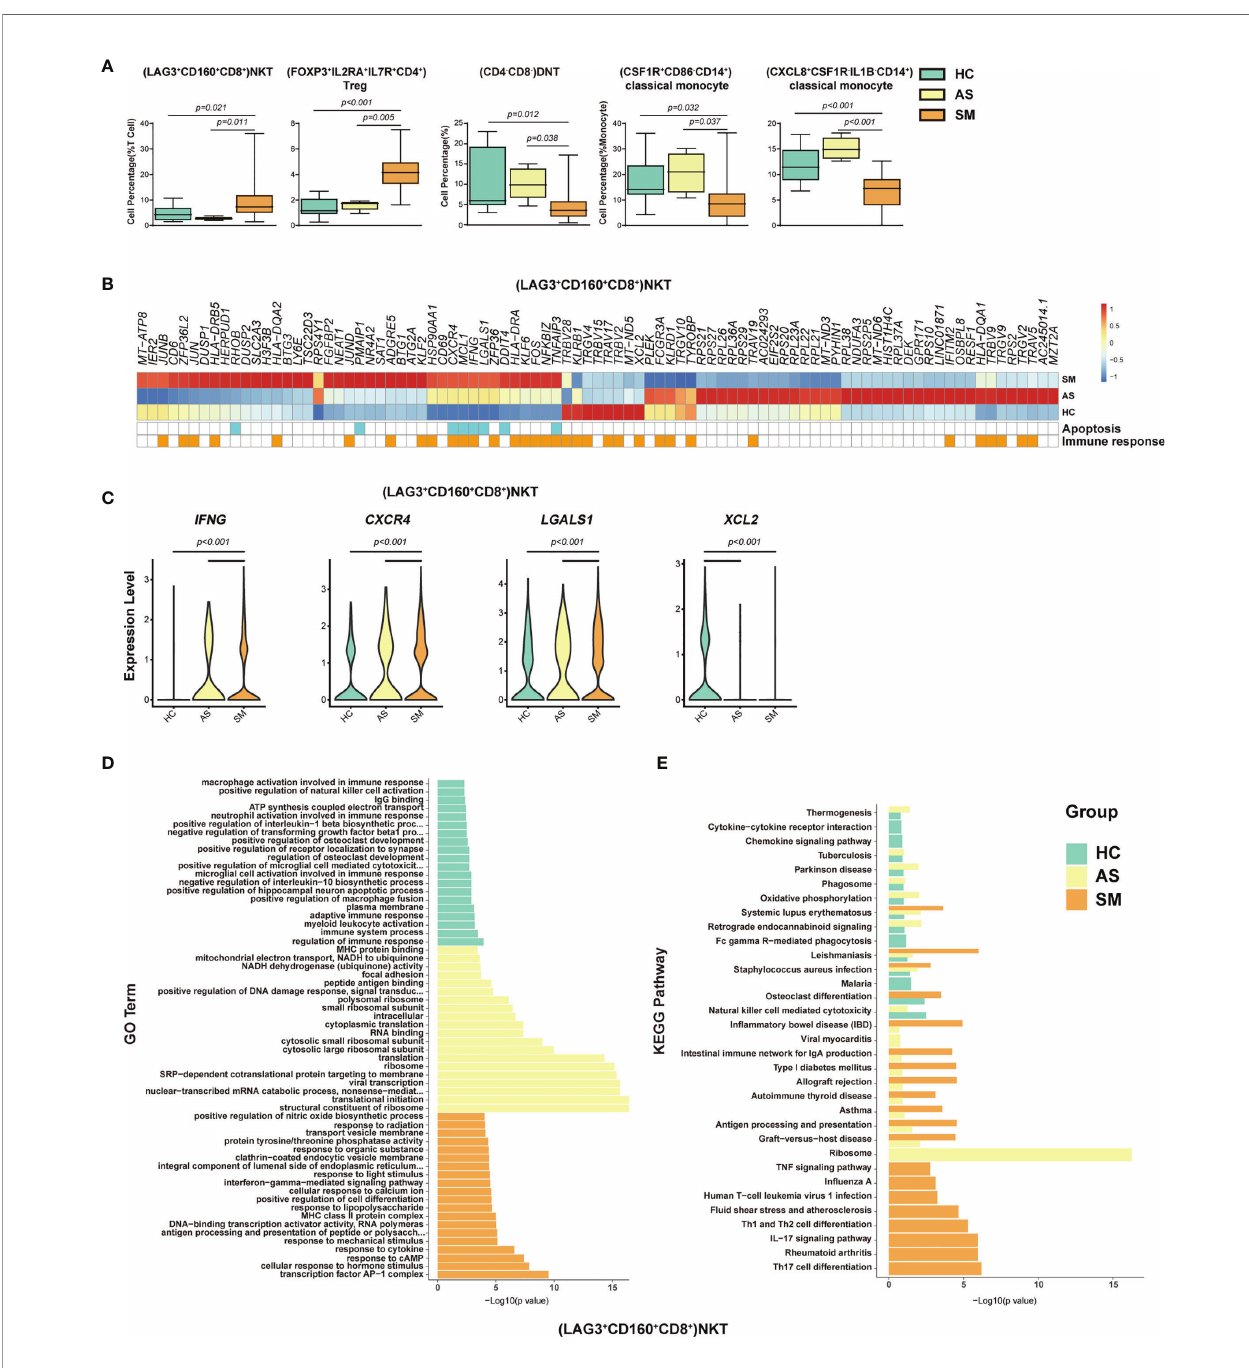
FIGURE 4 | Immune cell subsets associated with symptomatic COVID-19 patients. (A) The Box and whisker plots showing the percentage of fi ve distinct cell clusters that exhibited signi fi cant differences (p <0.05) between HC, AS, and SM groups. The horizontal lines, box and whiskers correspond to median values, interquartile range (IQR) and minimum/maximum value, respectively. (B) A Heatmap showing the average level of the DEGs in the (LAG3 + CD160 + CD8 + )NKT cells with p <0.05 and log2 fold change (FC) ≥ 0.26 in HC, AS and SM. The gene function (immune responses and apoptosis) is indicated in the heatmap. The gene expression was calculated via LogNormalize method of the “ NormalizeData ” function of the Seurat software. (C) The violin plots showing the expression levels of four representative DEGs ( IFNG, CXCR4, LGALS1 , and XCL2 ) in (LAG3 + CD160 + CD8 + )NKT cells, which were involved in apoptosis and/or immune responses. (D) Gene Ontology (GO) analysis. Top 20 signi fi cant GO terms sorted by − Gene Ontology (GO) analysis. Top 20 signi fi cant GO ter + CD160 + CD8 + )NKT cells. (E) KEGG pathway analysis. Top 20 signi fi cant KEGG pathways sorted by − log10 (p value) from HC, AS, and SM were shown in (LAG3 + CD160 + CD8 + )NKT cells (also see Figure S3 ). p <0.05 was considered signi fi cant. The samples included HC (n=11), AS (n=5) and SM (n=35, total 33 patients and two patients were sampled twice at different disease